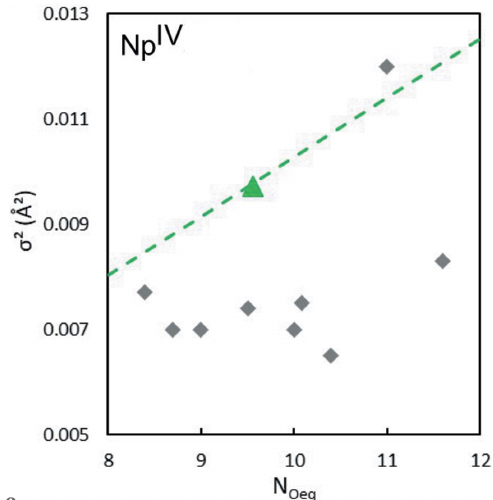
Figure 8 Plot of the (cid:4) 2 values as a function of coordination number from the EXAFS fit (dashed line) and comparison with previously reported values (Antonio et al. , 2001; Ikeda-Ohno et al. , 2008, 2009; Hennig et al. , 2009; Di Giandomenico et al. , 2009; Combes et al. , 1992; Allen et al. , 1997; Reich et al. , 2000; Scheinost et al. , 2016; Denecke et al. , 2005) (grey diamonds). The triangle shows the best fit results from this work.